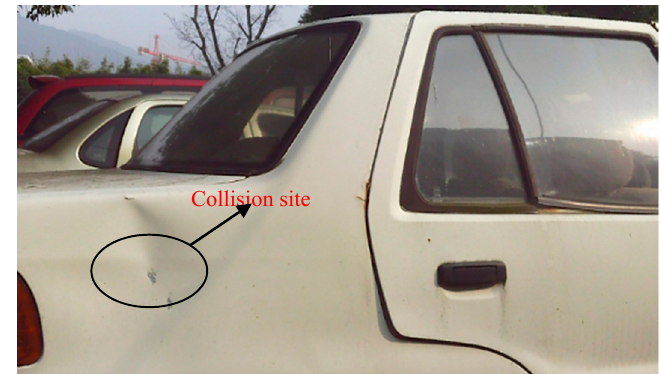
Figure 5. Deformation caused by a real accident.